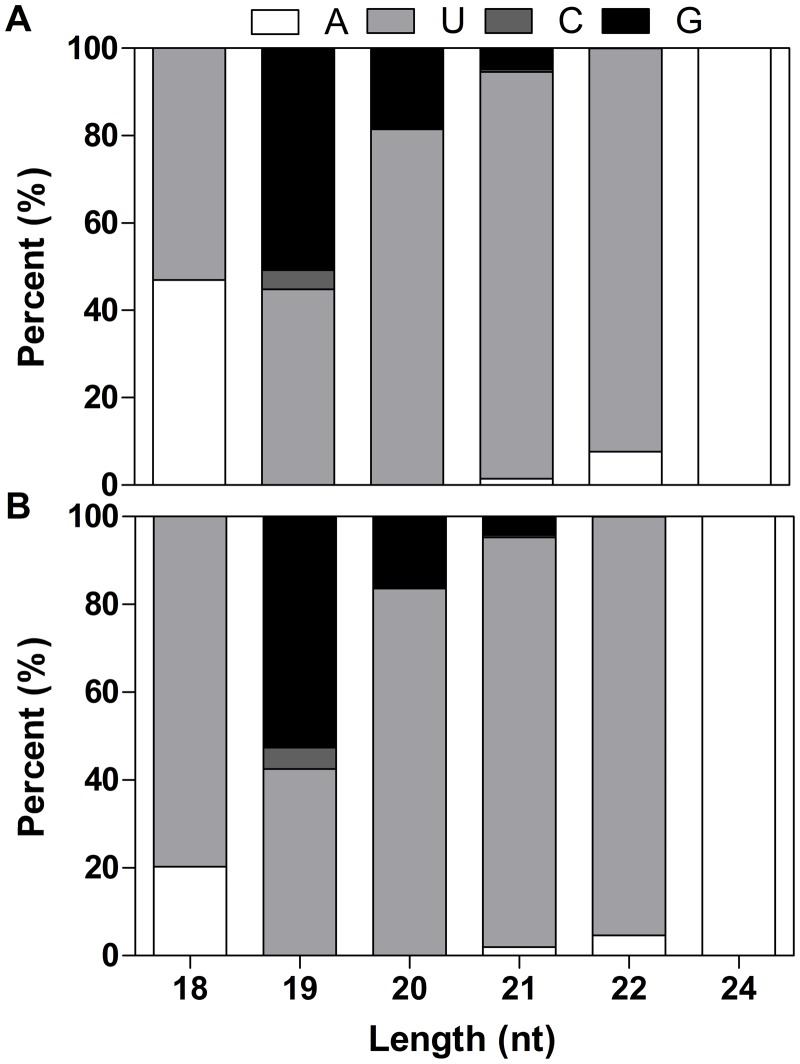
First nucleotide bias of novel miRNA in CK (A) and TR (B) libraries.